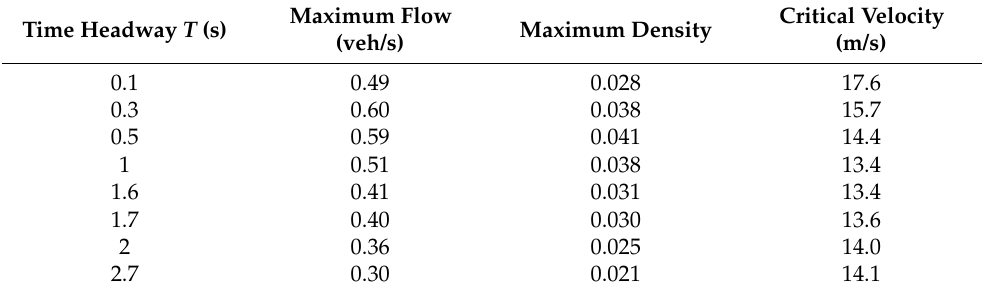
Critical Velocity (m/s)